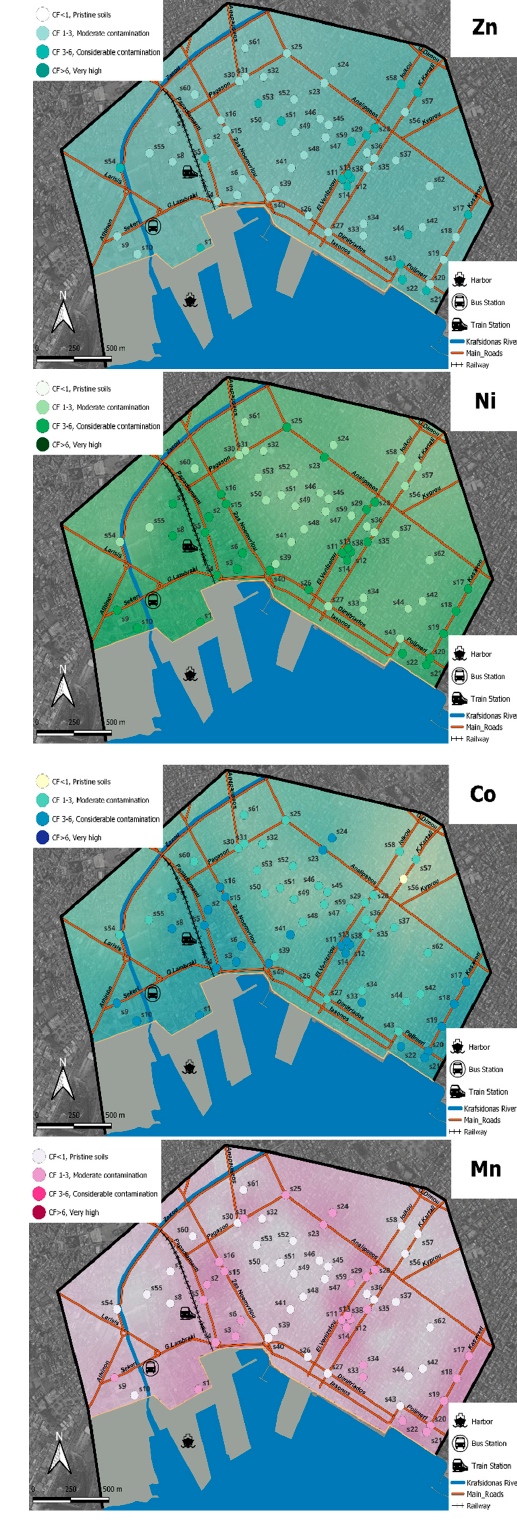
Figure 2. Thematic maps of heavy metals based on contamination factor (CF) values in Volos during the COVID ‐ 19 pandemic. Table 3. (a) Descriptive statistics for the contamination factor (CF) before the COVID ‐ 19 pandemic— heavy metals; geostatistical parameters, for the creation and validation of the contour maps. (b) De ‐ scriptive statistics for the contamination factor (CF) during the COVID ‐ 19 pandemic—heavy metals; geostatistical parameters, for the creation and validation of the contour maps.